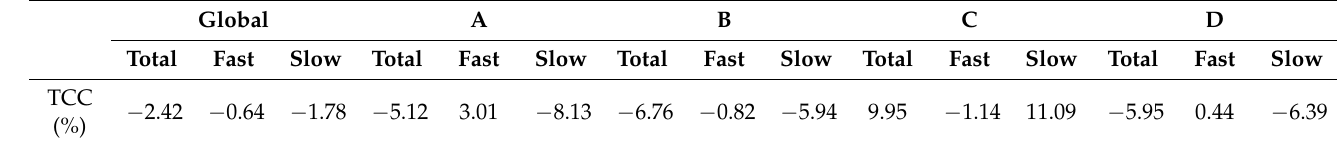
Table 2. Mean changes in total cloud cover in the globe and in four typical regions